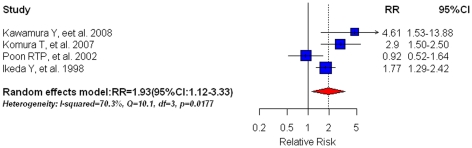
Summary estimate of relative risk (RR) for HCC recurrence-free survival (RFS) in HCC patients with pre-existing diabetes mellitus in comparison with non-diabetic patients.Squares represent study-specific estimates (size of the square reflects the study-specific statistical weight, i.e. inverse of the variance); horizontal lines represent 95% CIs; diamonds represent summary estimates with corresponding 95% CIs.